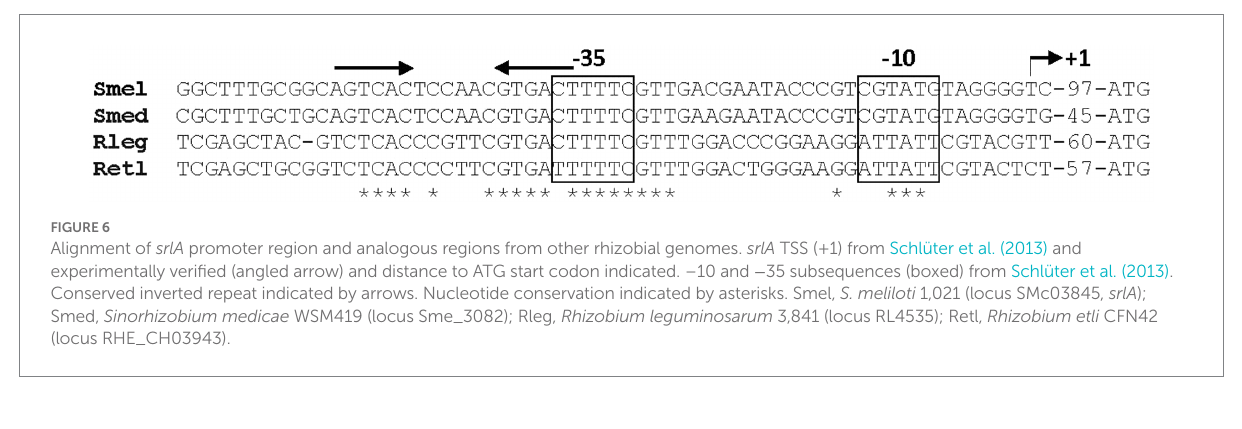
TABLE 1 Related inverted repeats in four promoter